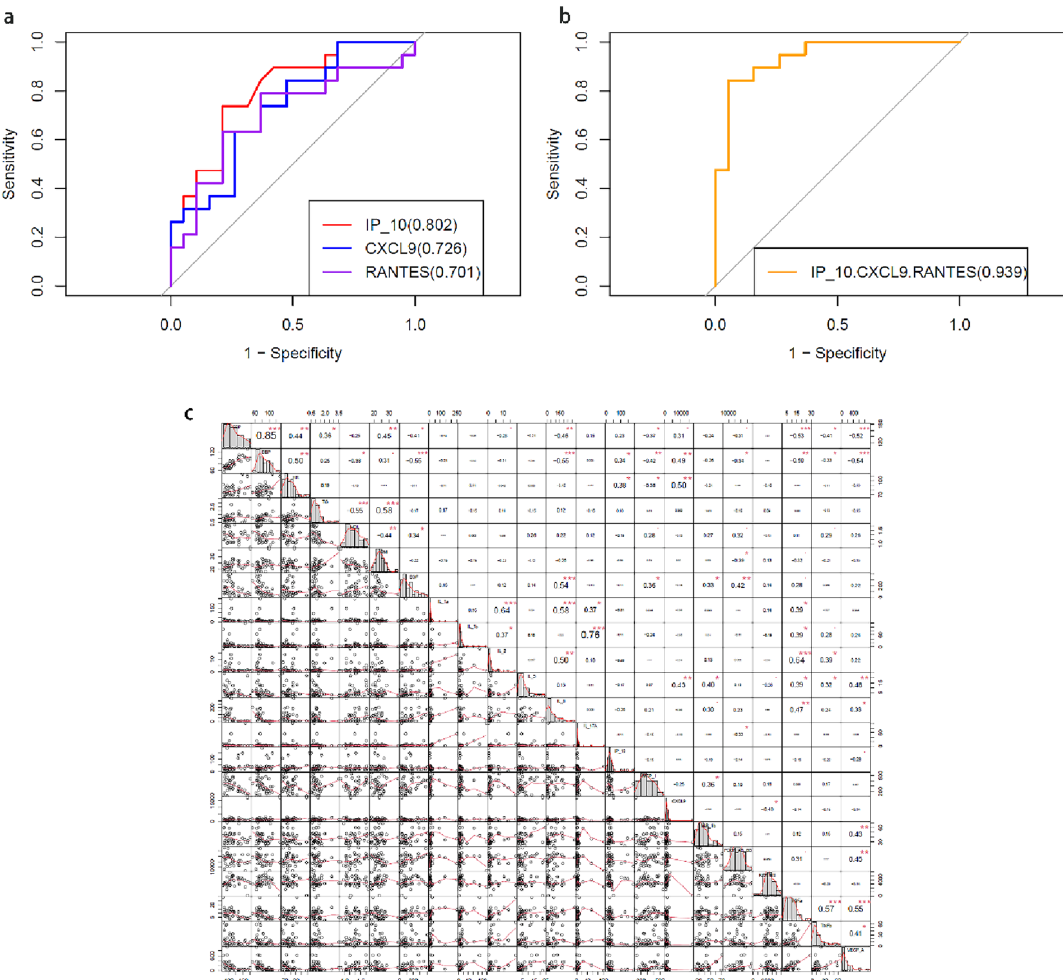
Figure 1. ( a ) ROC curves of single-indicator analysis of IP-10, CXCL9 and RANTES; ( b ) ROC curves of combined analysis of IP-10, CXCL9 and RANTES. ( c )The correlational analyses in the 16 statistically significant cytokines with the clinical indicators in the comparison of UPA group and control